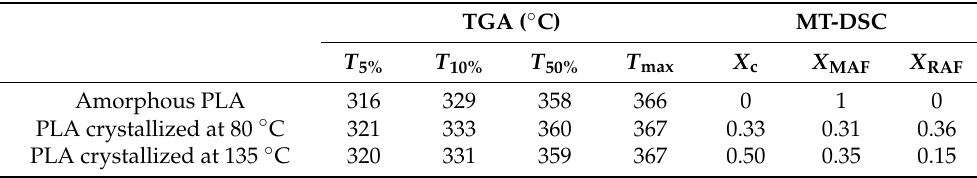
Table 1. TGA characteristic degradation temperatures and MT-DSC fraction contents.